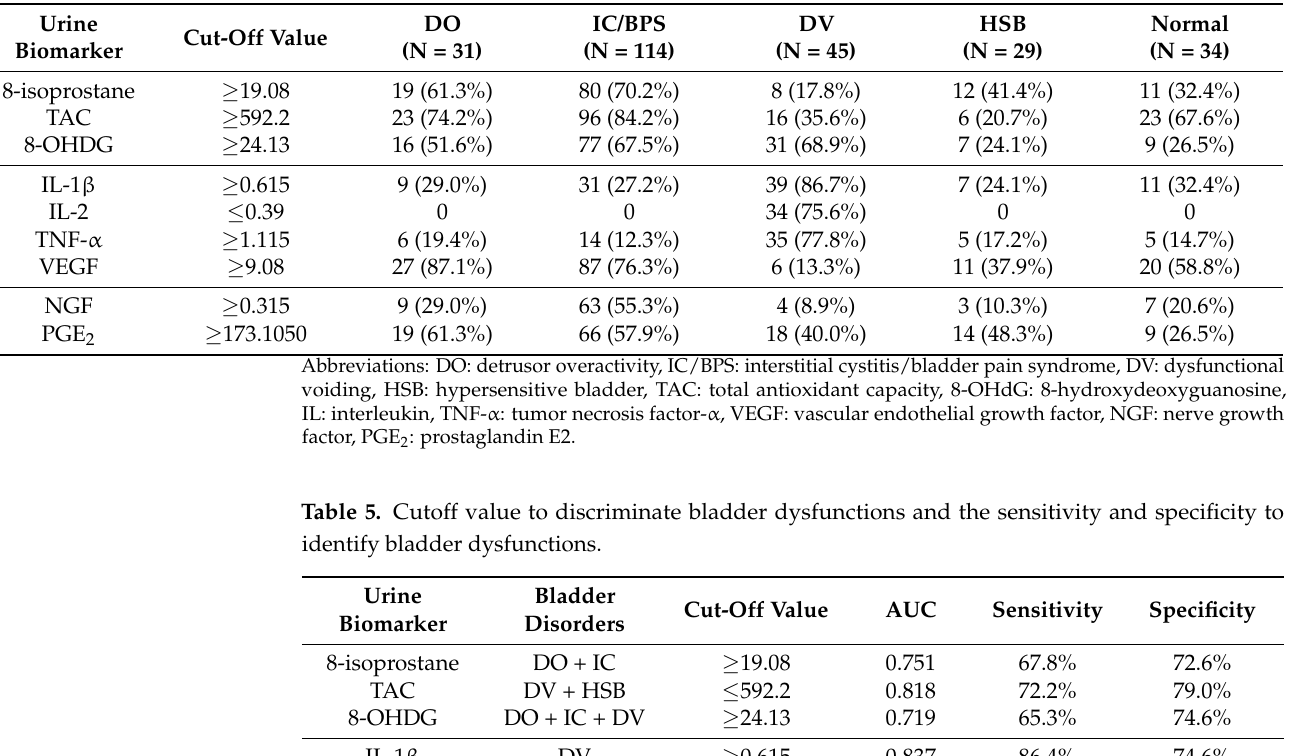
Table 4. Receiver operating characteristics curves and cutoff values of urine biomarkers in women with different bladder dysfunctions and normal tracing.